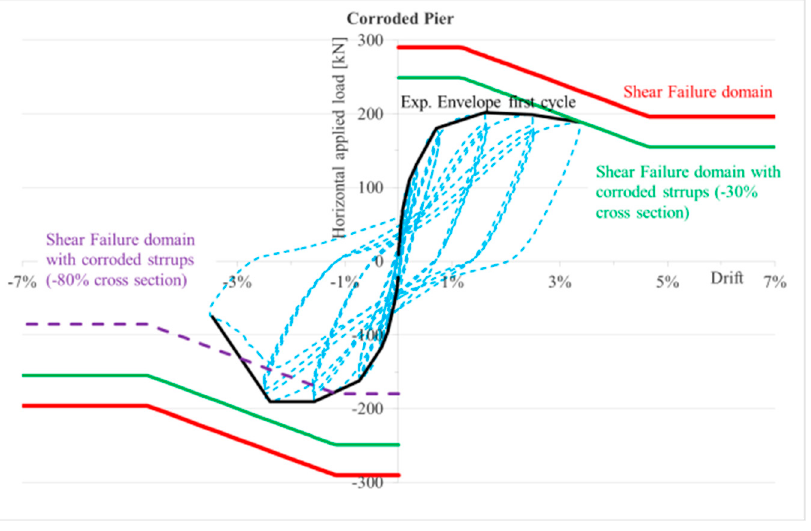
Figure 22. Envelope of first cycles at different drifts and shear failure domain at different cross-section reductions—rectangular pier.